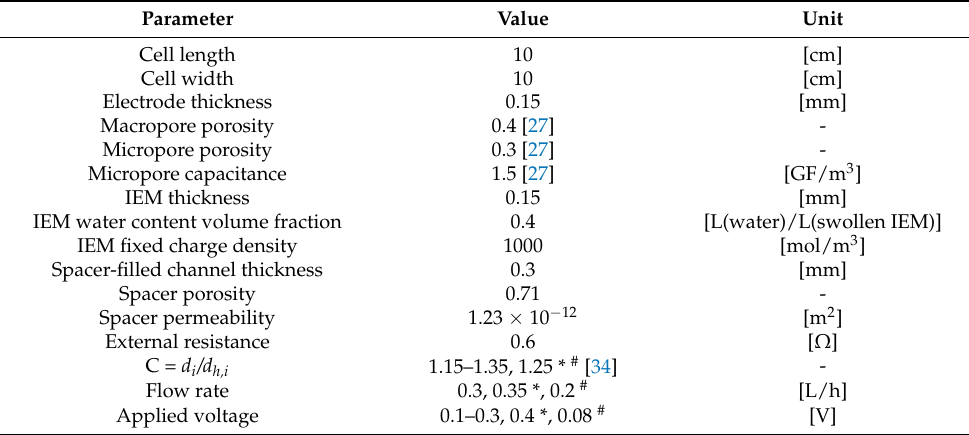
Table 2. Membrane capacitive deionization (MCDI) device parameters and operating conditions based on a single cell